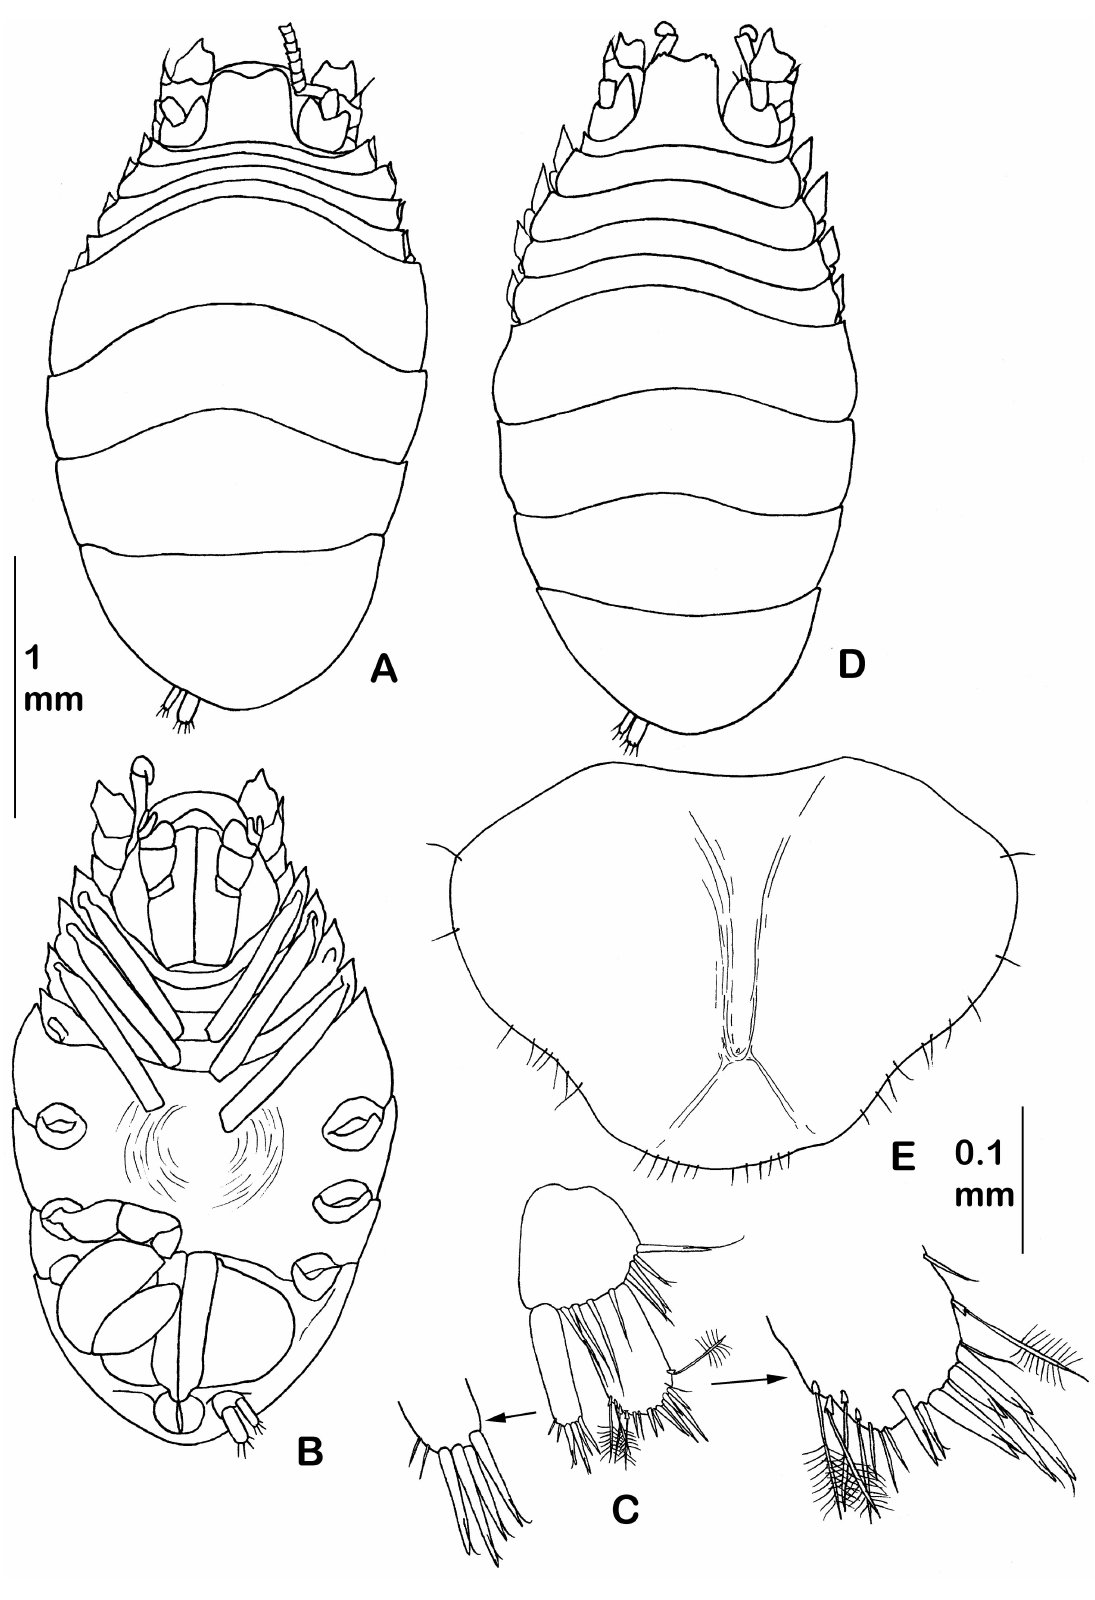
Figure 26. Eurycope emmae sp. nov. Male holotype (ZMH K-45652): ( A ) dorsal view; ( B ) ventral view; ( C ) uropod. Female paratype (ZMH K-45653): ( D ) dorsal view. Female paratype (ZMH K-45655): ( E ) pleopod